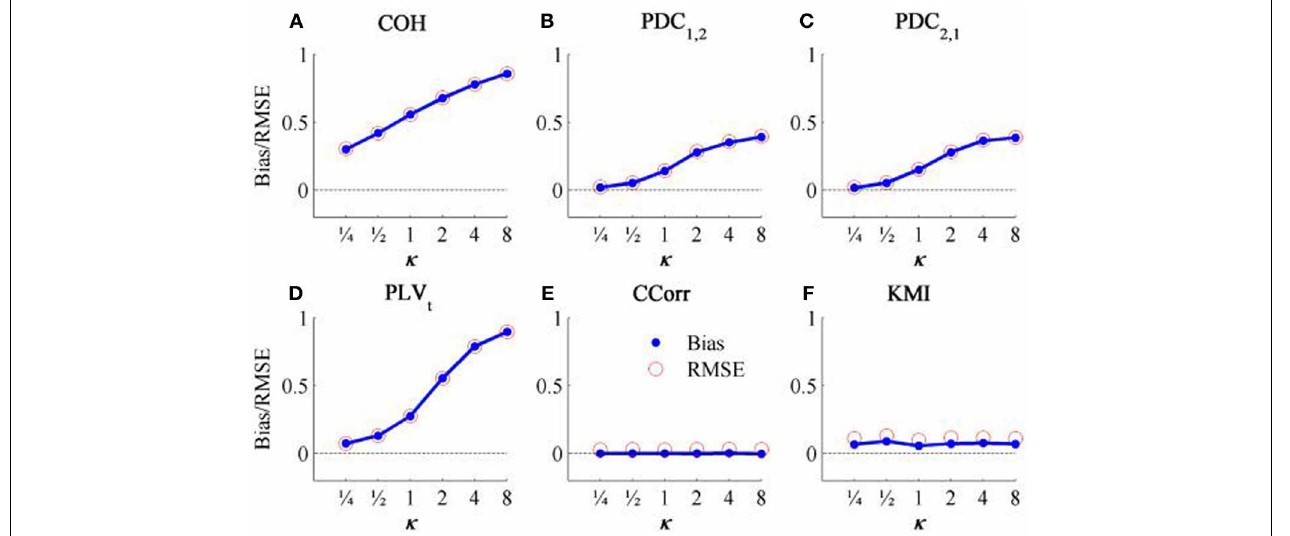
FIGURE 6 | The bias and RMSE for each connectivity measure estimated from the zero-lagged simulated data at different levels of concentration, κ , when the coupling, r = 0. Blue dots indicate bias and red circles RMSE. (A) Shows coherence, (B,C) partial directed coherence,